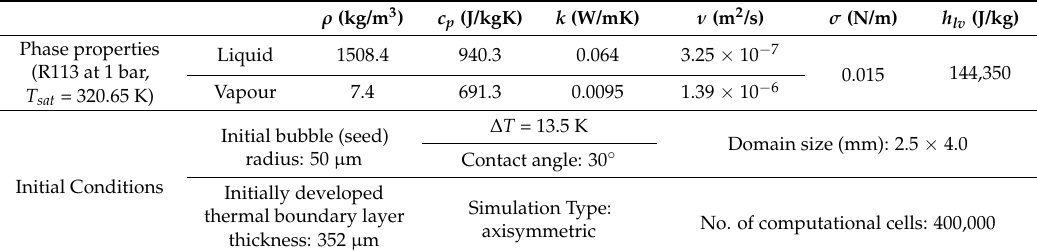
Table 2. Fluid properties and initial